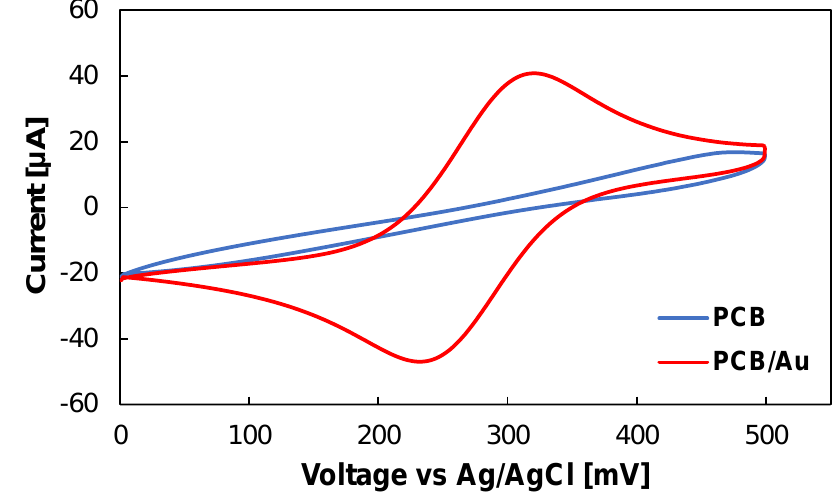
Figure 2. Cyclic voltammetry from − 100 to 500 mV vs Ag/AgCl, inside 0.1 M KCl containing 5 mM K 3 Fe(CN) 6 using PCB (blue line), and Au-plated PCB (red line) electrodes. The scan rate was 50 mV/s.